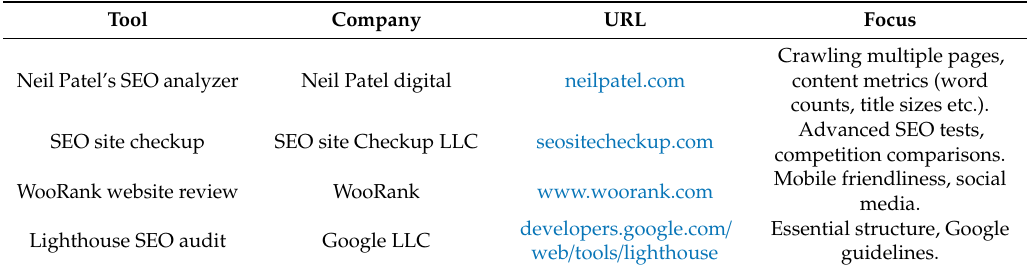
Table 6. Search engine optimization (SEO) tools overview.